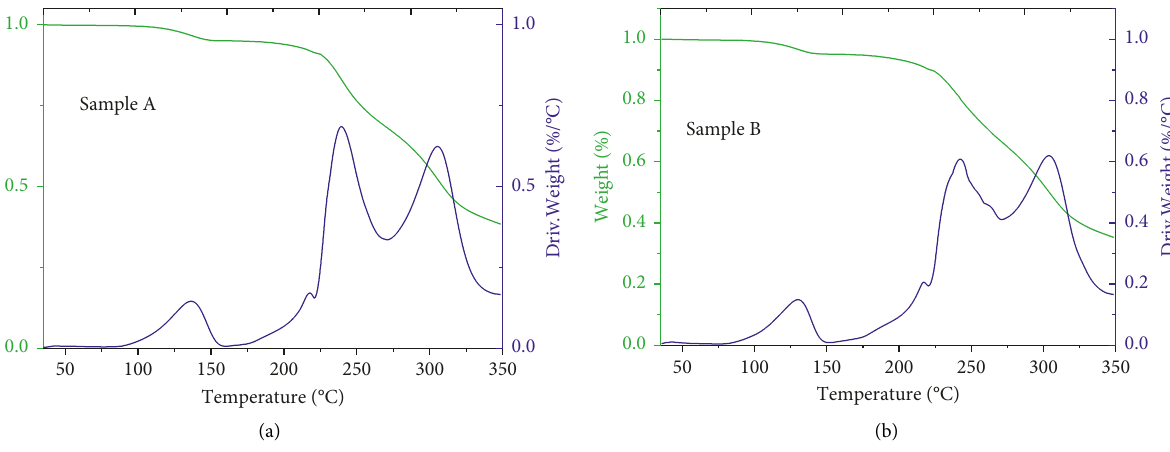
Figure 4: The TGA curves of the two spray-dried samples.